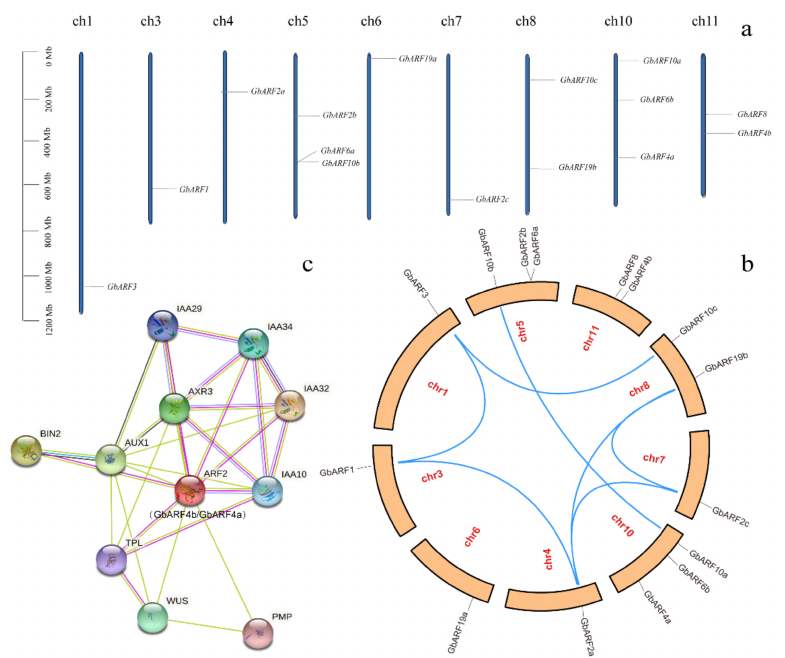
Figure 4. Physical chromosomal location, collinearity analysis and protein interaction of GbARFs . ( a ) Physical chromosomal location of GbARFs . ( b ) Duplicated relationship of GbARF genes. ( c ) A putative protein interaction network of GbARF4b and GbARF4a .